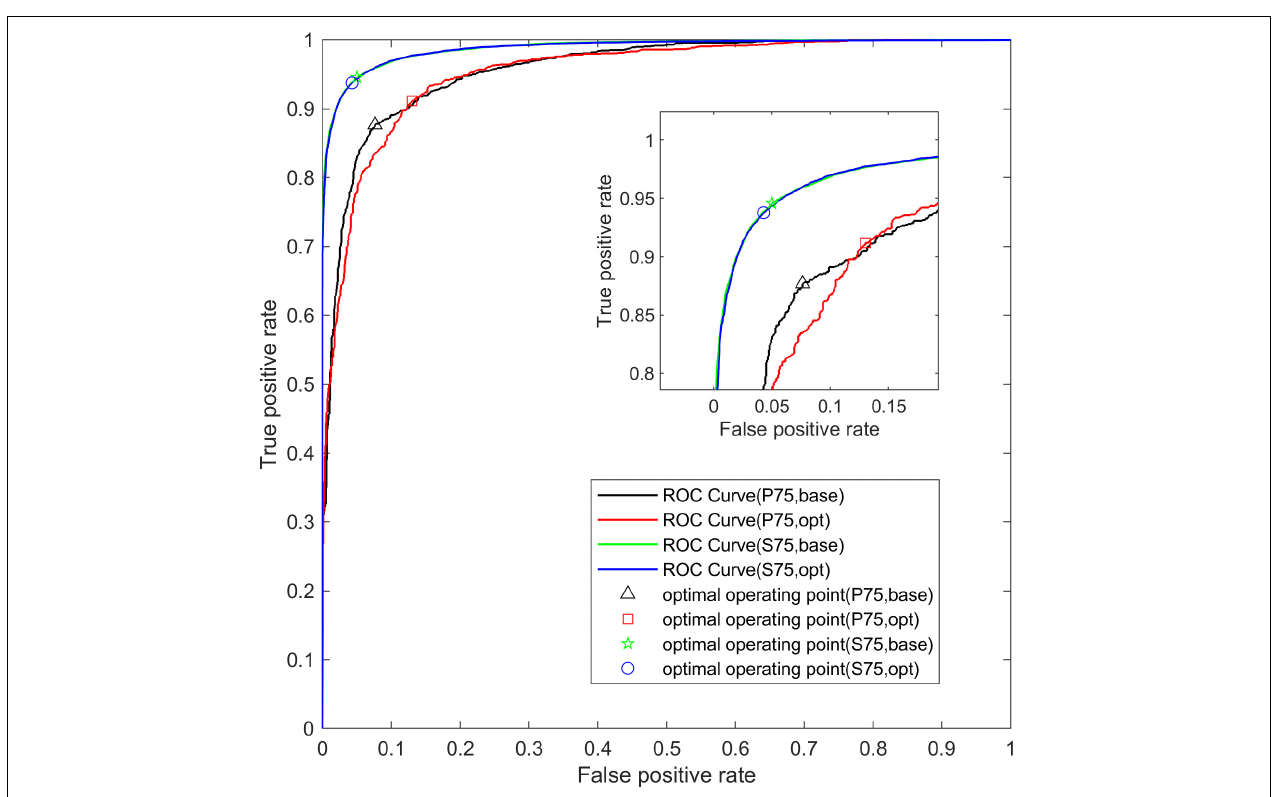
FIGURE 9 | The average ROC curve of two network structures. The abscissa is False Positive Rate (1-Specificity) and the ordinate is True Positive Rate (Sensitivity).